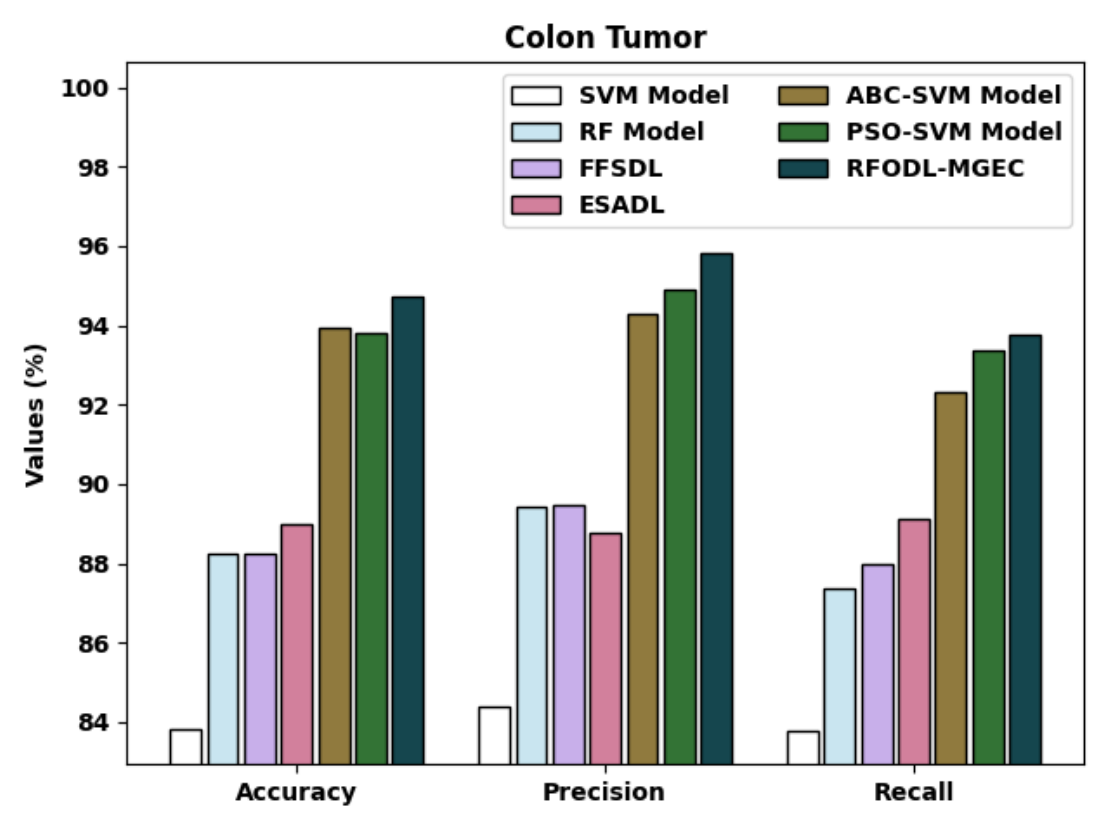
Figure 13. Comparative analysis of RFODL-MGEC technique with colon tumor dataset.